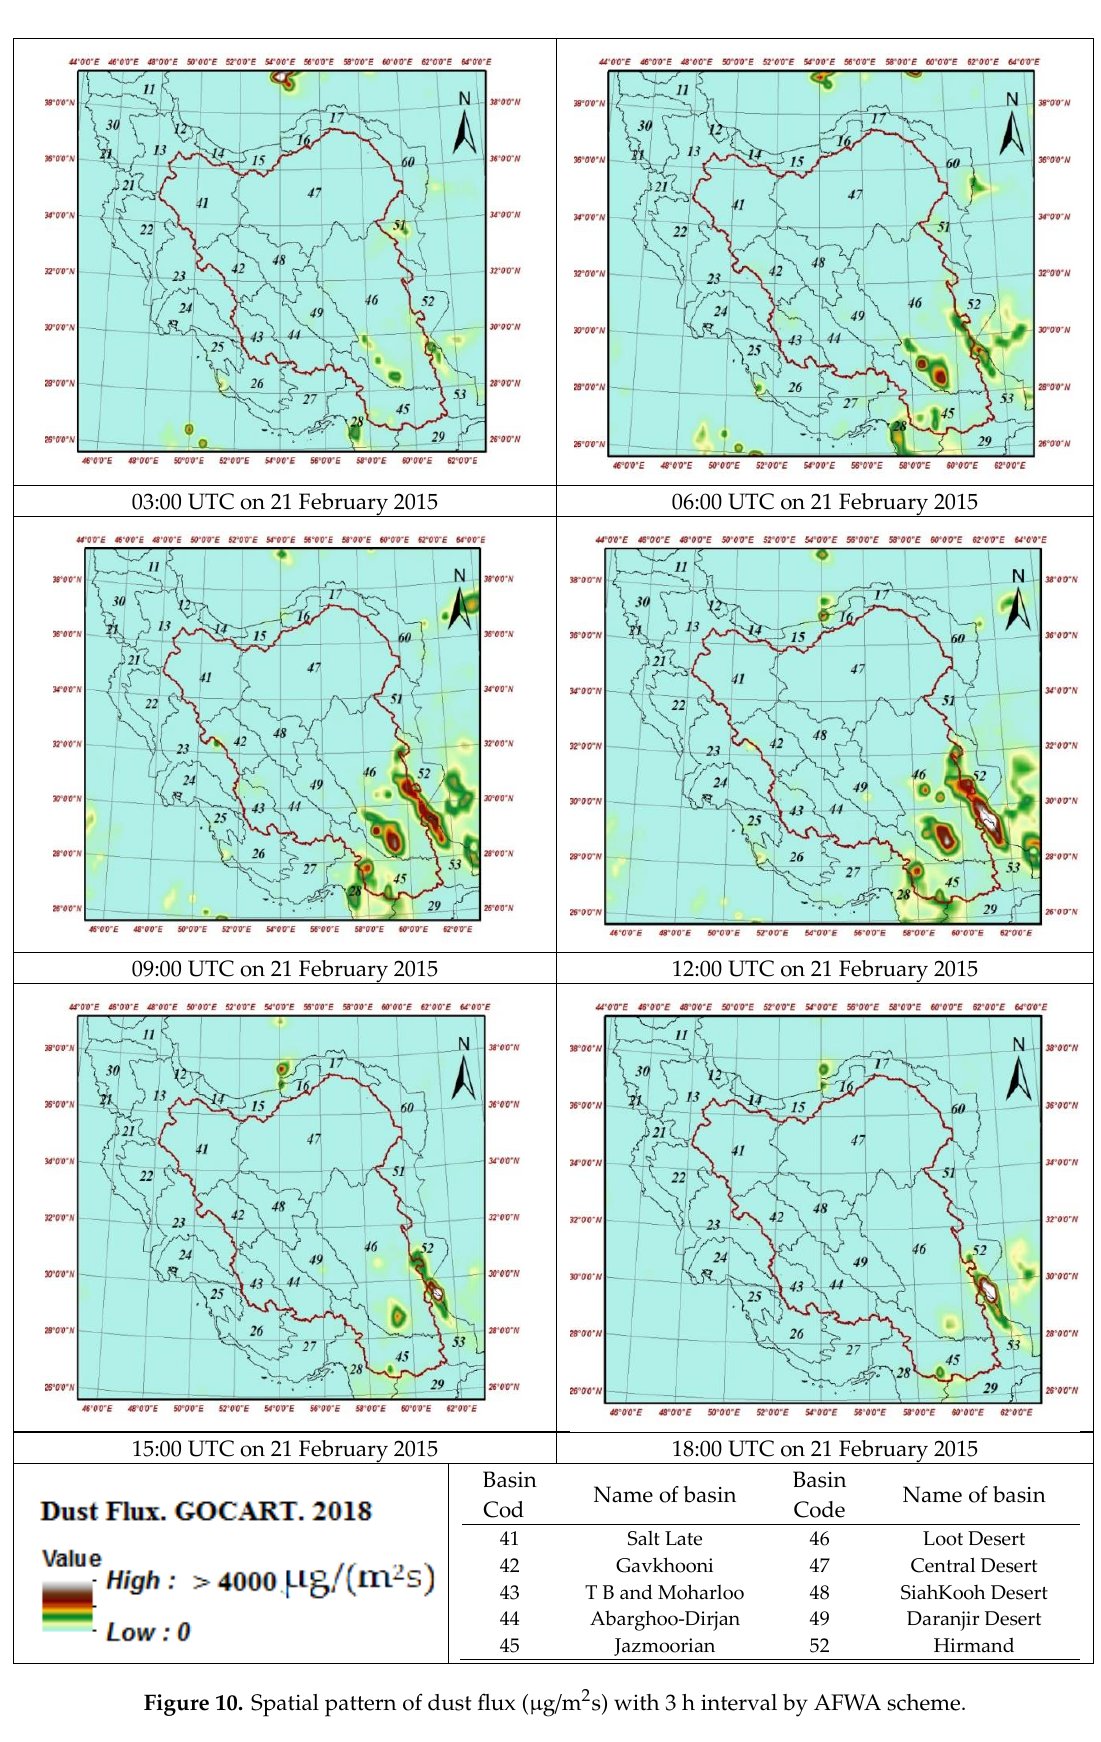
Figure 10. Spatial pattern of dust flux ( µ g / m 2 s) with 3 h interval by AFWA